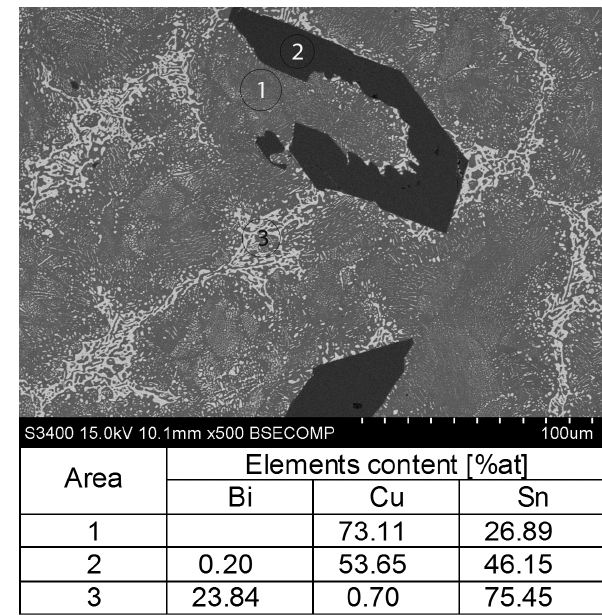
Figure 13: Microstructure of the alloy no 8.